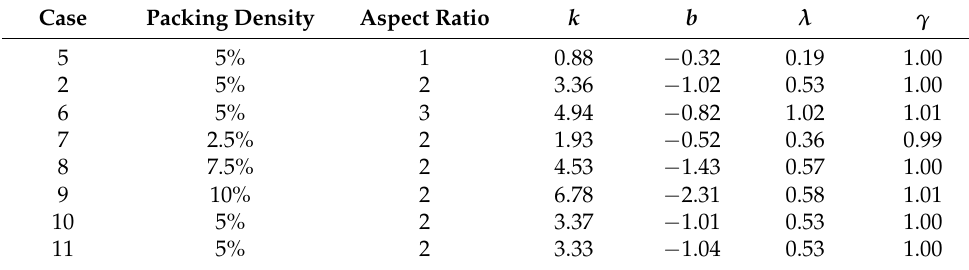
Table 3. Fitting parameters of the simulation